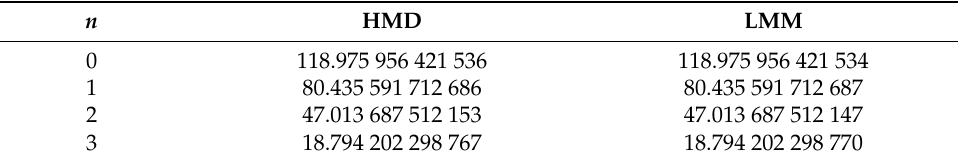
The negative of the complete energy spectrum (in units of 1/ a 2 ) for the poten- tial V I ( x ) obtained using LMM and HMD techniques for the potential parameter values: { a , A , B , C } = { 1,10,1000,250 } making N = 19. For the LMM, the variational parameter h = 0.1 and a grid size M = 100 are used, whereas for the HMD, the scale parameter λ = 80 and a matrix size M = 100 are considered. See text for